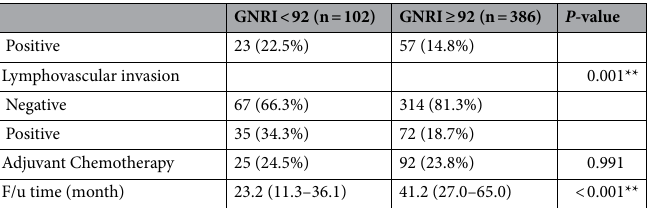
Table 1. Demographic (N = 488). GNRI geriatric nutritional risk index, BMI body mass index, ECOG Eastern Cooperative Oncology Group, HTN hypertension, DM diabetes mellitus, COPD chronic obstructive pulmonary disease, CAD coronary artery disease, HBV Hepatitis B virus, HCV Hepatitis C virus, UCUB urothelial carcinoma in urinary bladder, eGFR estimated Glomerular filtration rate, CIS carcinoma in situ. Chi-